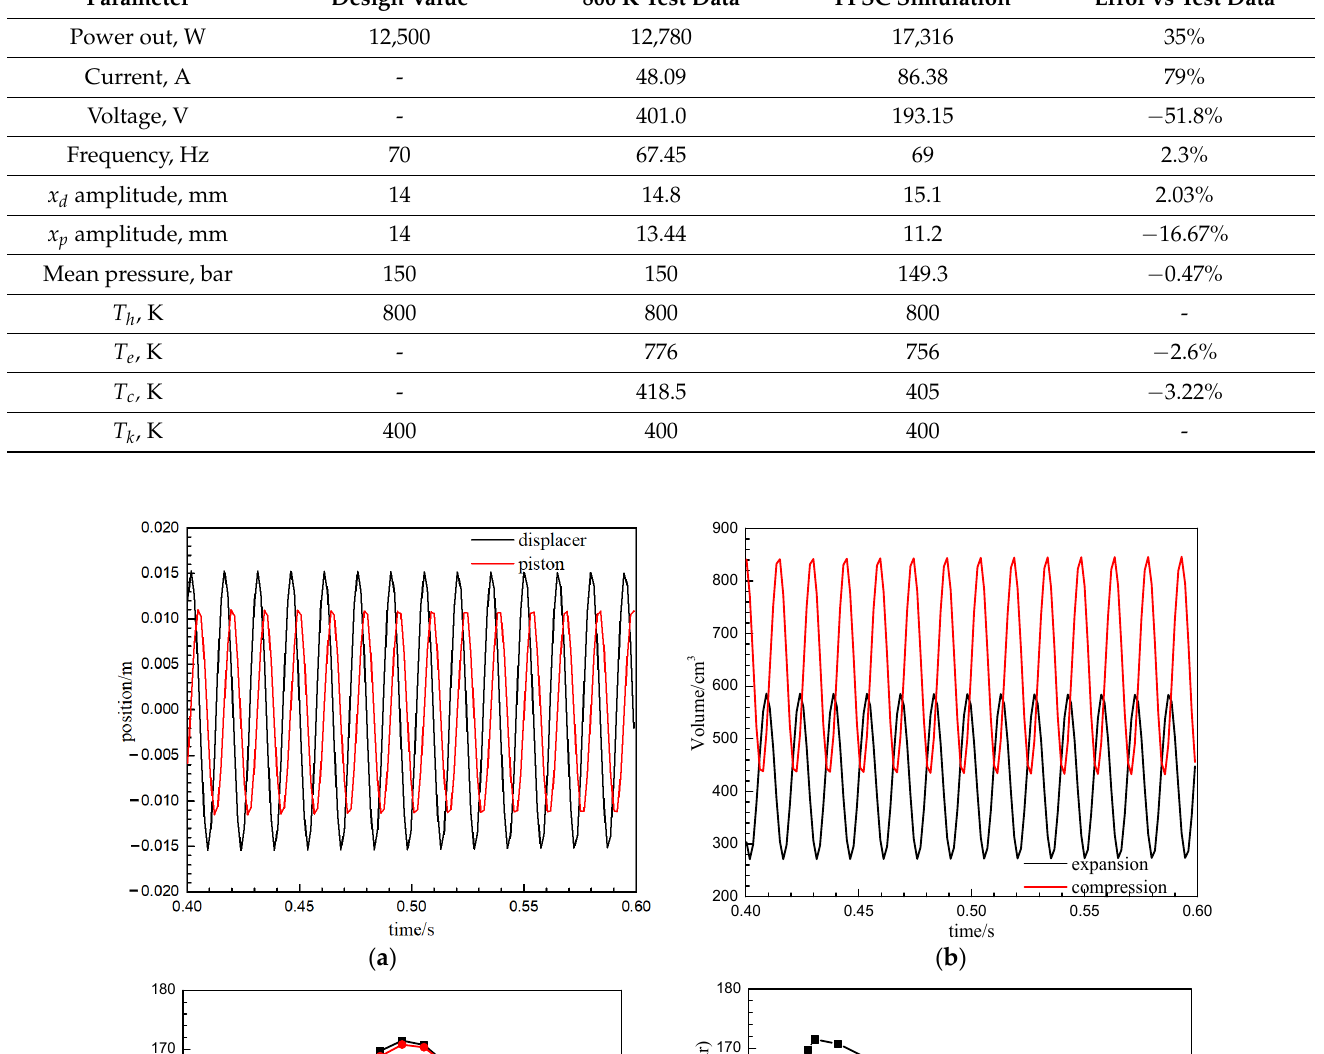
Table 4. CTPC model simulation results versus test data.